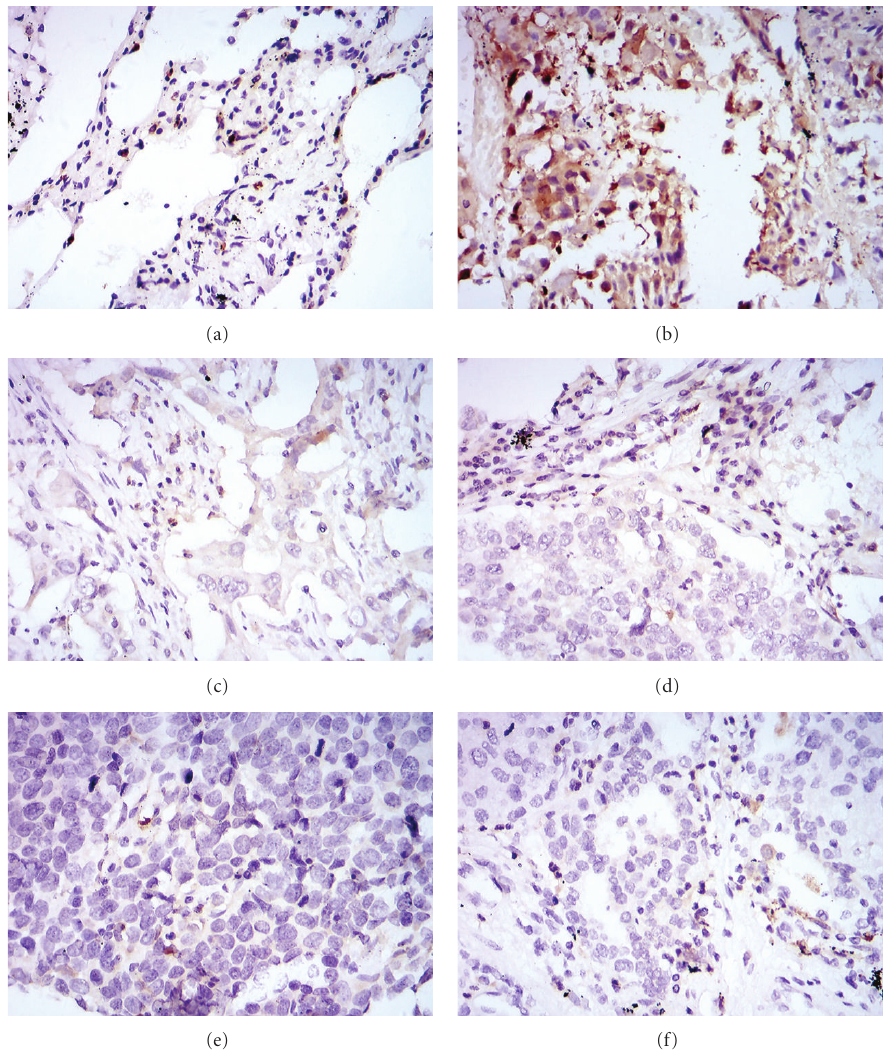
Figure 5: Immunohistochemistry staining in tissue chip of S100A8 protein expression in lung cancer tissue and normal tissues ((a) normal lung tissue, (b) lung squamous cell carcinomas, (c) metastatic carcinoma, (d) adenocarcinoma, (e) small cell carcinoma, (f) large cell carcinoma tissues).